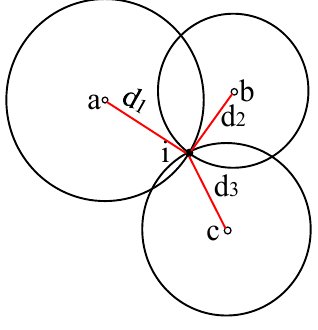
Figure 5. Target node localization.